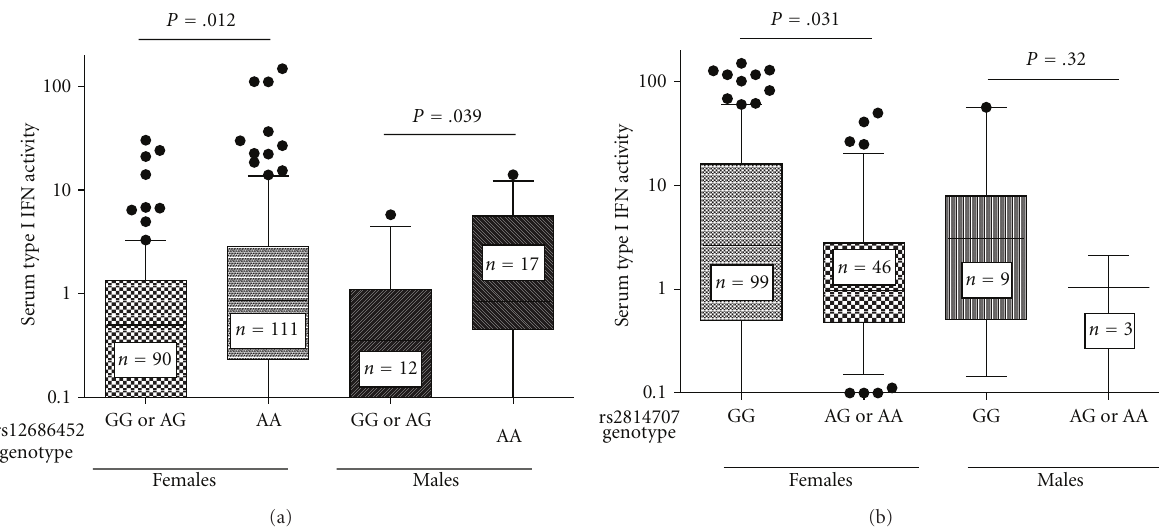
Figure 4: Serum type I IFN levels in SLE patients stratified by IFNK genotype. Serum type I IFN activity in European (a) and African- American (b) ancestry SLE patients is shown, stratified by genotype at the associated SNP in each ancestral background. Minor allele homozygotes are combined with the heterozygous state in each case due to low numbers. Serum type I IFN activity is reported in relative units (see methods for derivation of IFN activity). Data are nonnormally distributed, so the box-and-whiskers format is used, with lines indicating the median, boxes showing the interquartile range, and error bars showing the 10th and 90th percentiles. P values were calculated using a nonparametric Mann-Whitney U test.